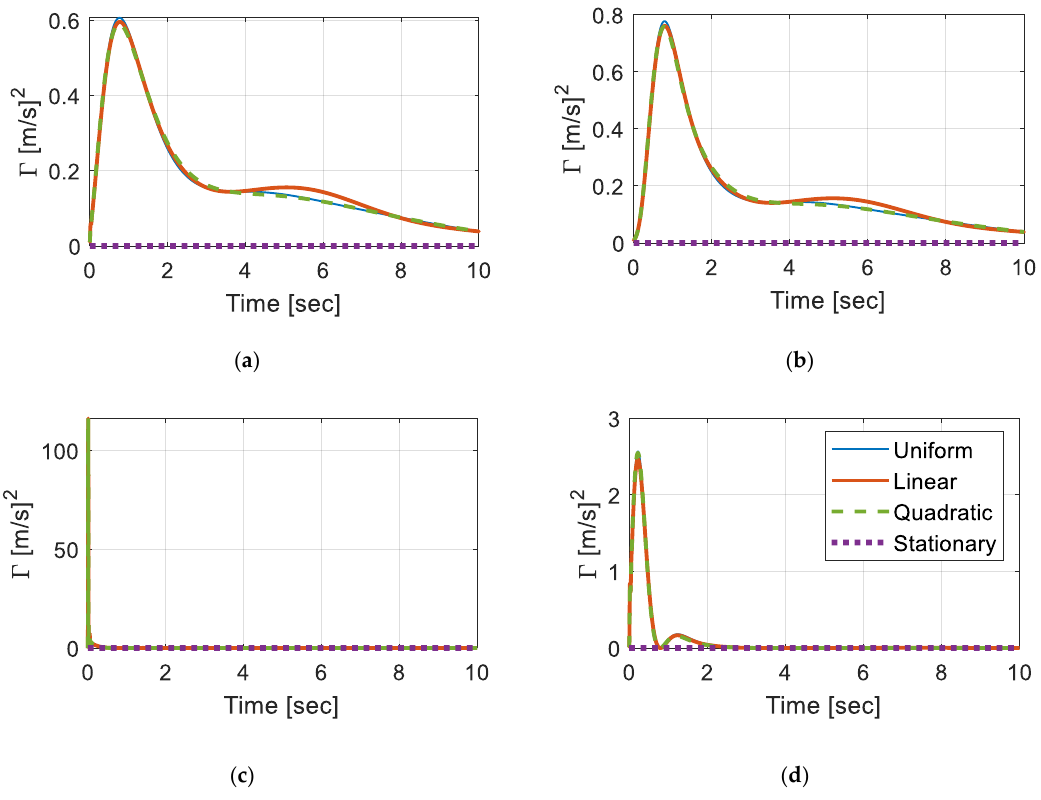
Figure 3. Covariance response of the vehicle over time ( a ) Γ u